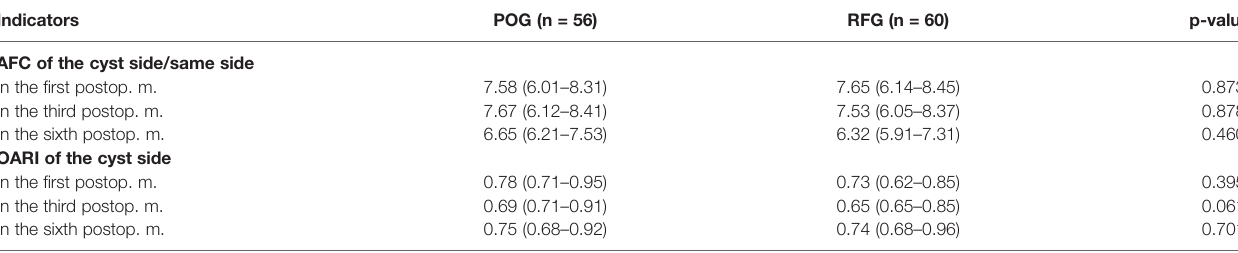
In the fi rst postop. m.